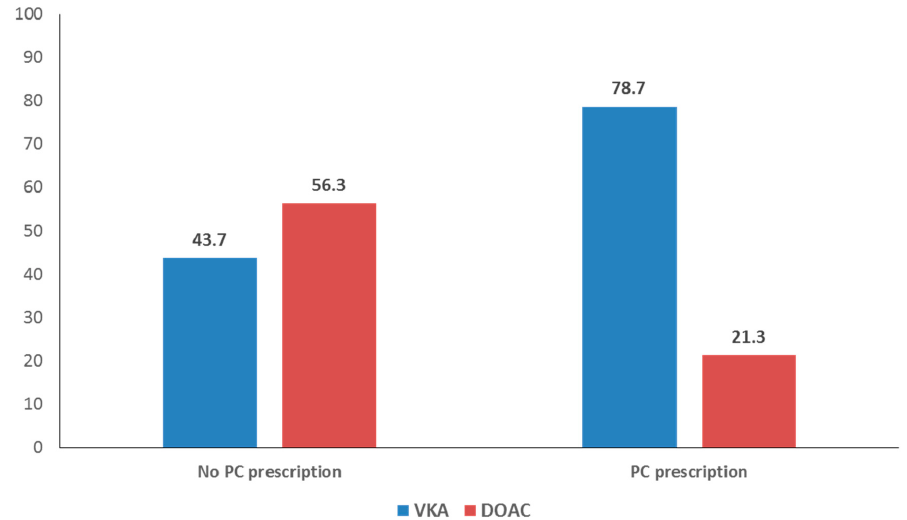
Figure 2. Proportional distribution of prescriptions for vitamin K antagonists (VKA) versus direct oral coagulants (DOAC) according to whether medication was prescribed inside or outside of a Primary Care center. different types of oral anticoagulants (VKA versus DOAC) based on the characteristics of patients and the PCC area. The main factors associated with the type of drug prescribed were gender, socioeconomic deprivation of the urban area and rurality.